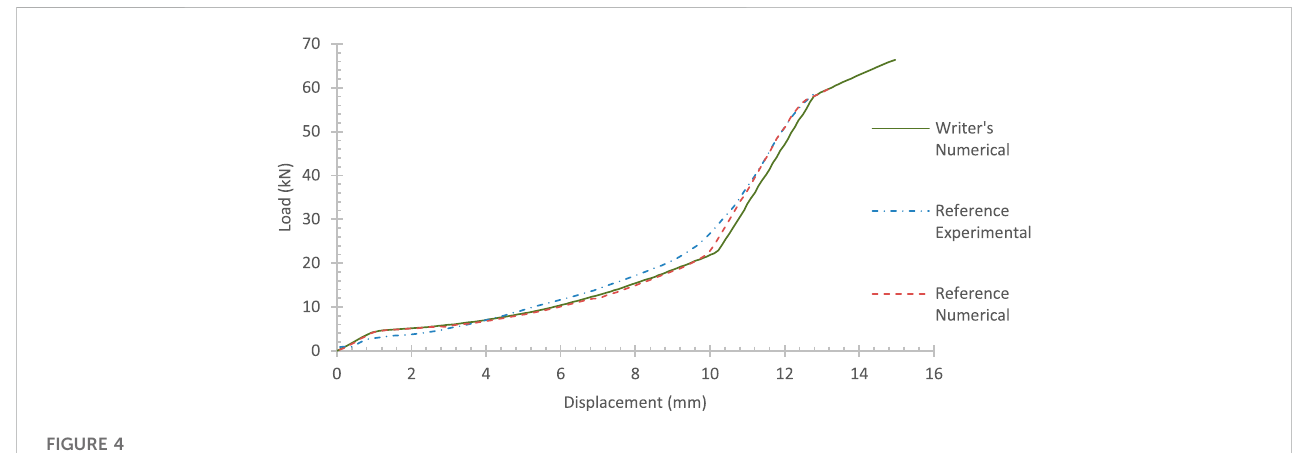
Comparison of force curve between reference and writer ’ s